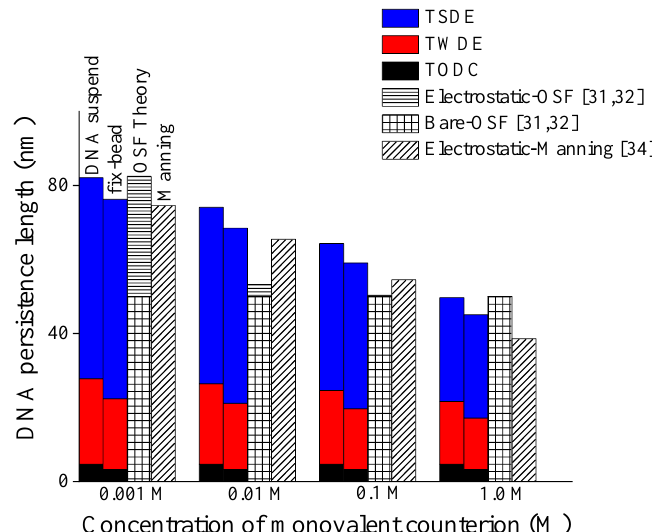
Figure 4. Respective contributions of three addictive terms (TODC, TWDE, TSDE) to persistence length of DNA with different end-constraints versus monovalent salt concentration.